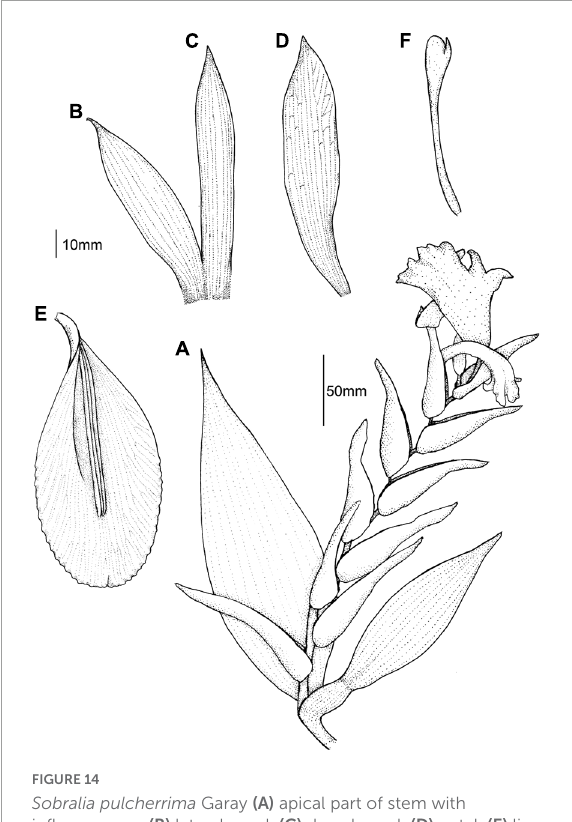
FIGURE14 Sobralia pulcherrima Garay (A) apical part of stem with inflorescence, (B) lateral sepal, (C) dorsal sepal, (D) petal, (E) lip, and (F) gynostemium, side view (drawn by P. Baranow from Asplund 16728 ).